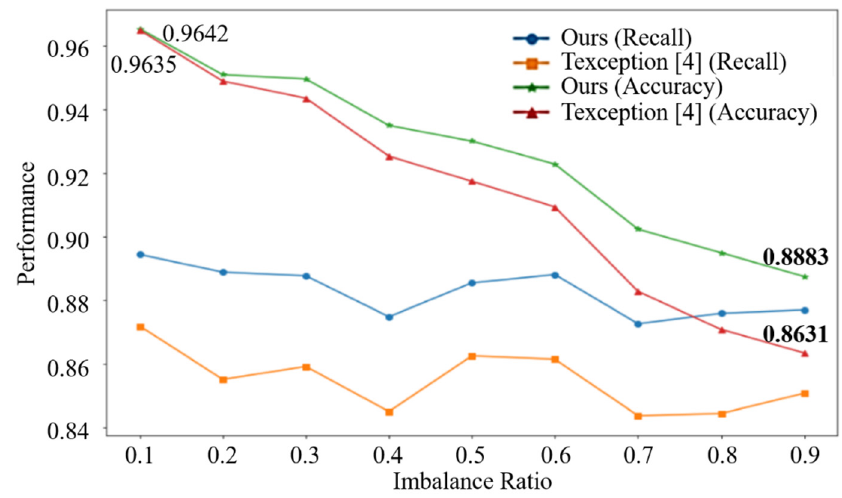
Figure 6. Receiver-operating characteristic (ROC) analysis to show the improvement of recall with the comparative study. ( a ) Comparison of ROC curves in the range of true positive rates [0.8, 1.0]; ( b ) Comparison in [0.0, 1.0] range of ROC curve of Texception Network.